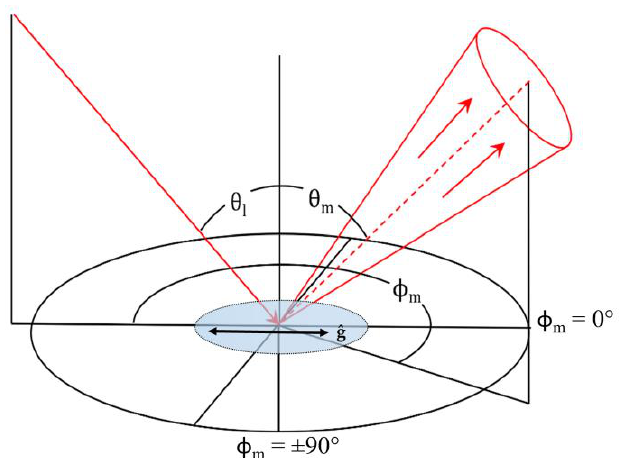
Figure 3. The coordinate system nomenclature of the custom goniophotometer. θ I corresponds to the illumination angle; θ m to the measurement (viewing) angle; φ m to the azimuthal measurement angle as displacement from the plane of incidence. A polymer opal was placed at the center of the focused optics, with the direction of BIOS shear, ˆg ,